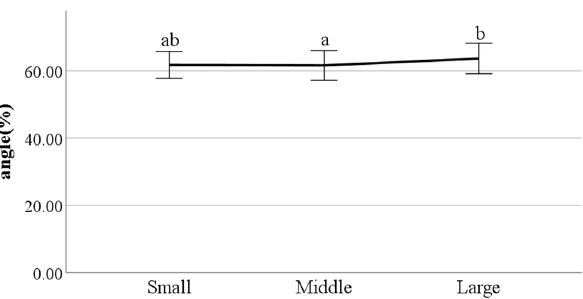
Figure 25. The ratio of stance phase of left foot (F value: 3.93, DF: 2, p -value: 0.02).